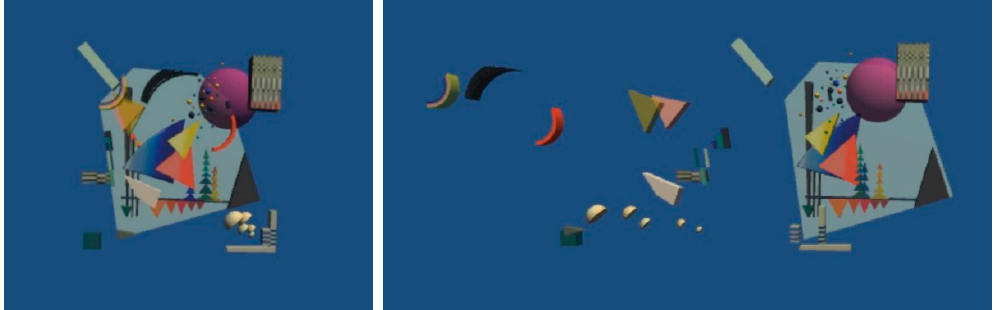
Figure 11. Explore Kandisky: original view ( left ), editable 3D expansion ( right ).